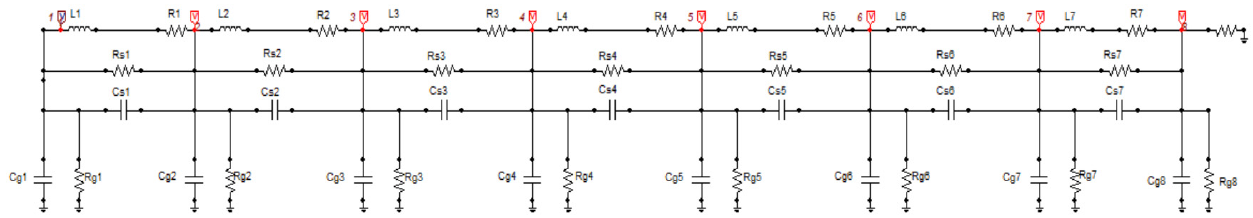
Figure 3. Equivalent circuit model of transformer windings.